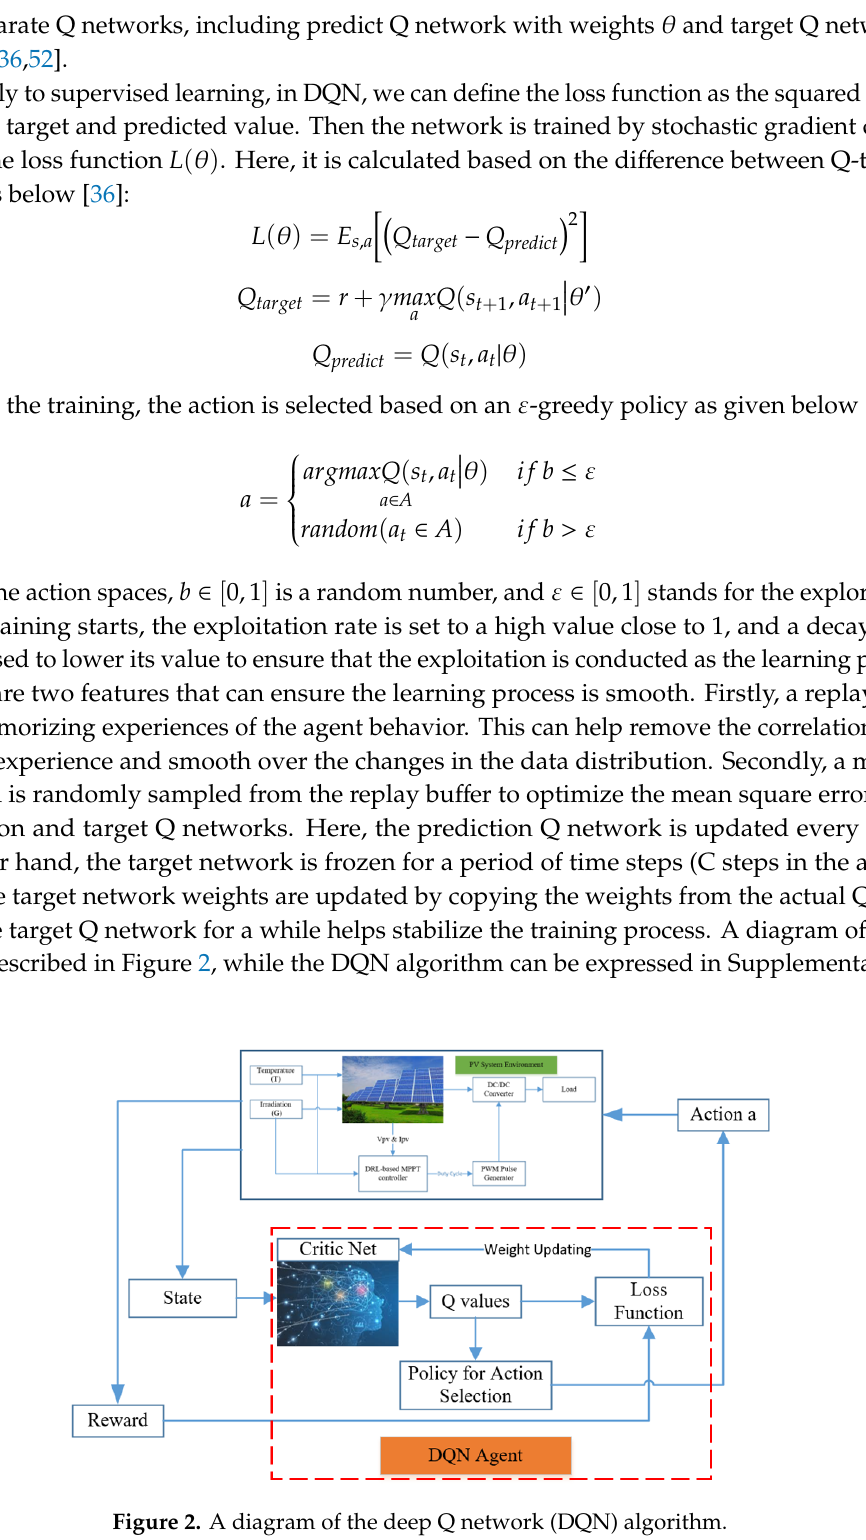
Figure 2. A diagram of the deep Q network (DQN) algorithm.